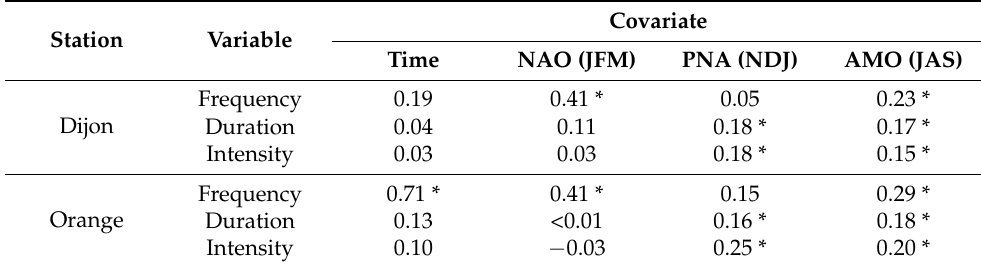
Table 1. Correlation coefficients between the heat spell variables and